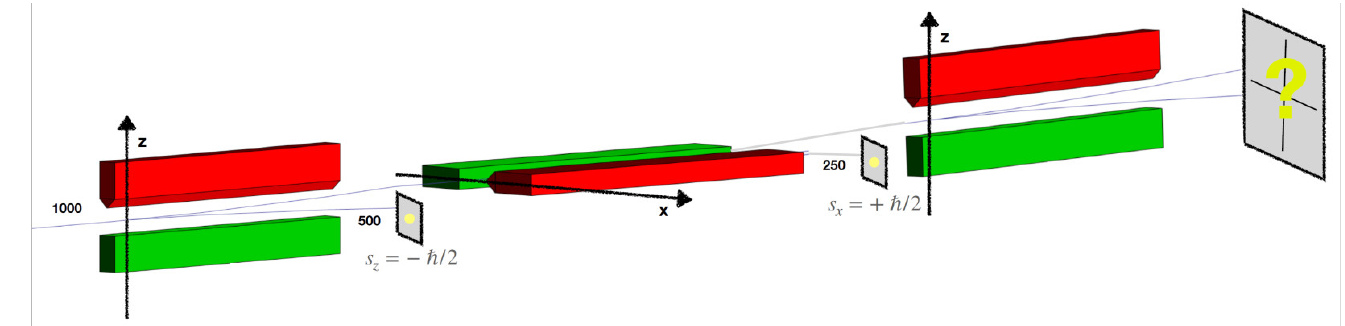
Figure 4. Third lecture: QuVis simulation of Stern–Gerlach experiment. 1000 spins pass through a z-magnet, after which a measurement is performed detecting 500 of the spins in a spin-down state (along z). The remaining spin-up states pass through an x-magnet, after which a measurement is performed detecting half of the spins in a spin-up state (along x). The remaining 250 spins finally pass through a second z-magnet. The students are then asked (notified by a question mark) what they do expect would be the outcome of a measurement, after the latter process. s z = ‒ ħ/ 2 and s z = + ħ/ 2 define the spin down and up z-components, respectively, and ħ is the Planck’s reduced constant.